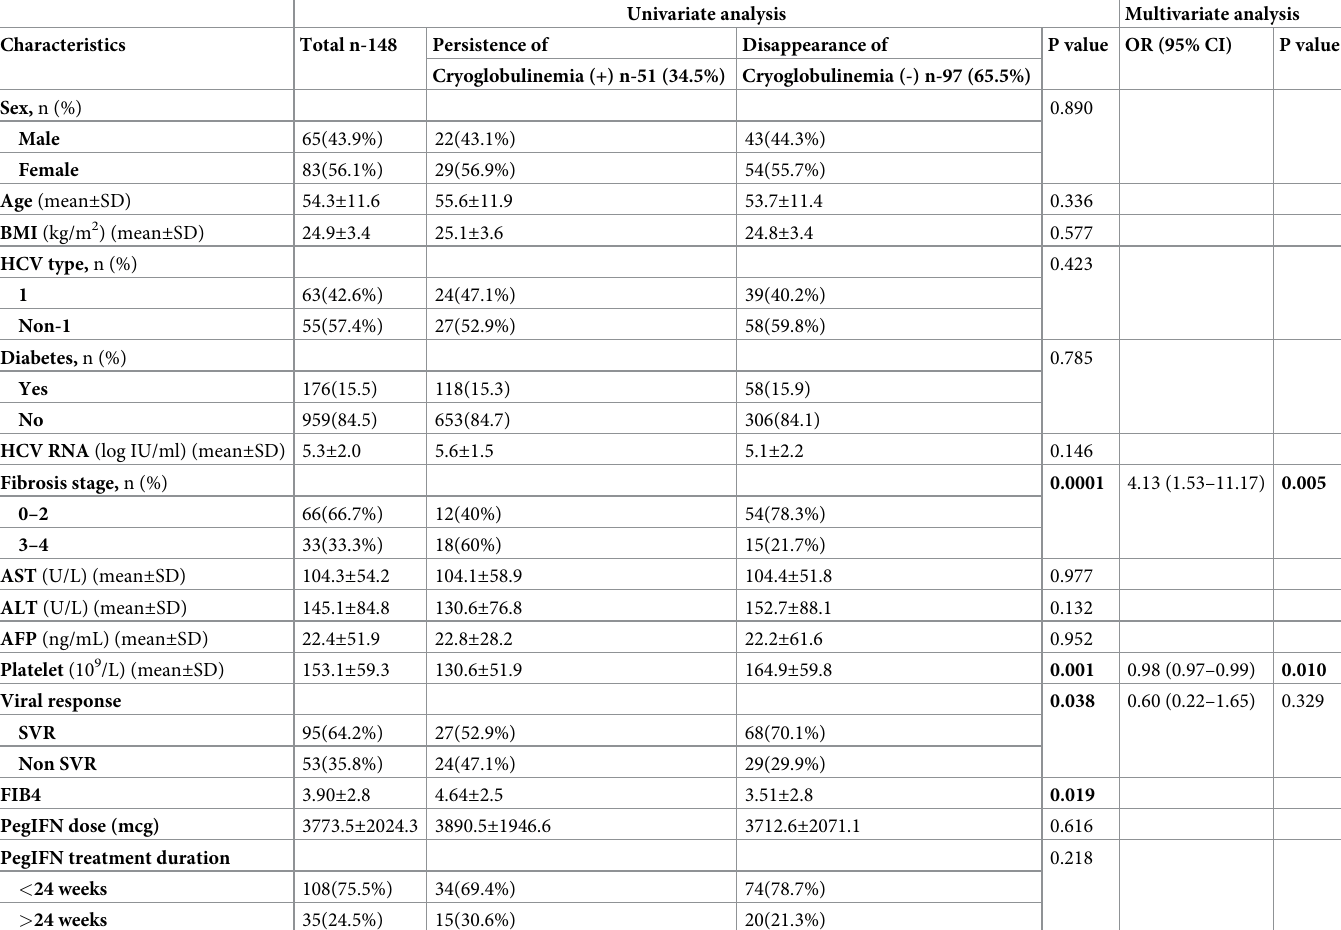
Table 1. Baseline characteristics of patients with follow up after antiviral therapy.